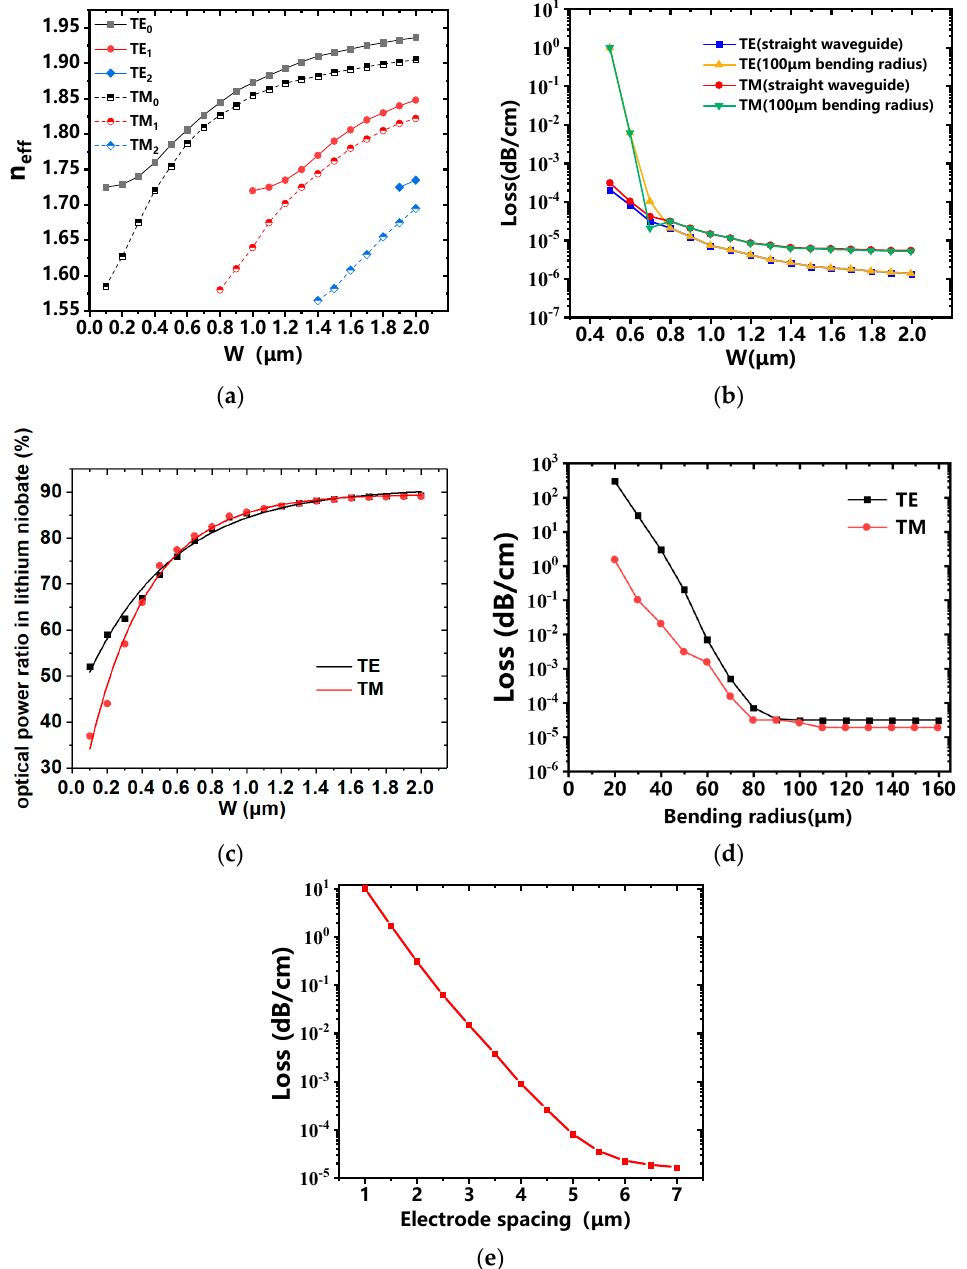
Figure 3. ( a ) The e ff ective refractive index at di ff erent waveguide width; ( b ) the waveguide loss at di ff erent waveguide width; ( c ) the optical power ratio in lithium niobate at di ff erent waveguide width; ( d ) the waveguide loss at di ff erent bending radius; and ( e ) the transmission loss of the LN waveguide with di ff erent electrode spacing.